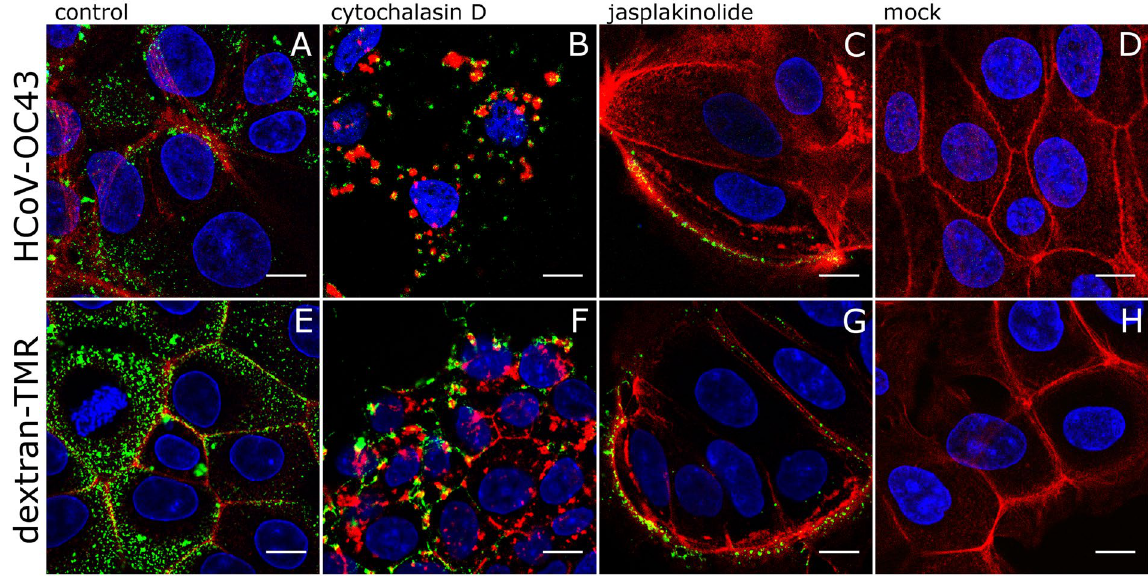
Figure 8. Inhibition of HCoV-OC43 infection in HCT-8 cells by compounds interfering with the actin cytoskeleton. HCoV-OC43 or dextran entry to the cell was studied using confocal microscopy. Following 1 h incubation of cells with inhibitors, cells were inoculated with HCoV-OC43 ( A – C ) or fluorescently labelled dextran ( E – G ) and incubated for 1 h. HCoV-OC43 and dextran are shown in green, actin cytoskeleton is presented in red. Nuclei are shown in blue. control HCoV-OC43/dextran-TMR inoculated inhibitor-untreated cells; cytD ( B,F ) HCoV-OC43/dextran-TMR inoculated, 2 μ M cytochalazine D-treated cells; jasp ( C,G ) HCoV-OC43/dextran-TMR inoculated, 150 nM jasplakinolide-treated cells; mock ( D,H ) mock-inoculated inhibitor-untreated cells. Scale bar = 10 μ m. The experiment was conducted at least thrice, and representative images are presented.